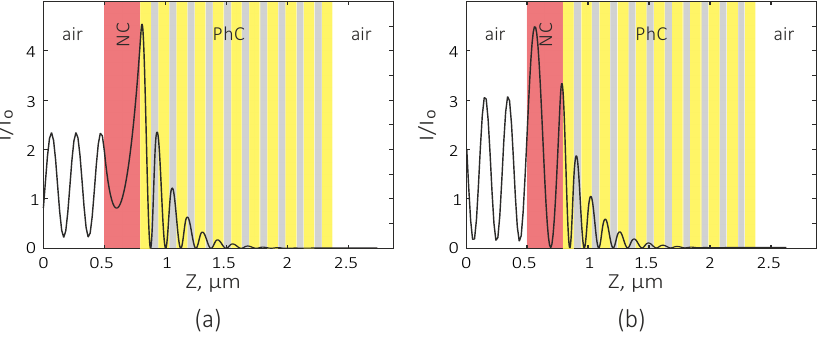
Figure 3. Schematic of a one-dimensional PhC (yellow - SiO 2 , grey - ZiO 2 ) conjugated with the nanocomposite layer (red) and field intensity distribution (solid black line) at the frequencies of ( a ) TPP ( ω = 0.3377 ω p ) and ( b ) defect mode ( ω = 0.3470 ω p ) normalized to the input intensity. The nanocomposite layer thickness is d eff = 300 nm and f =